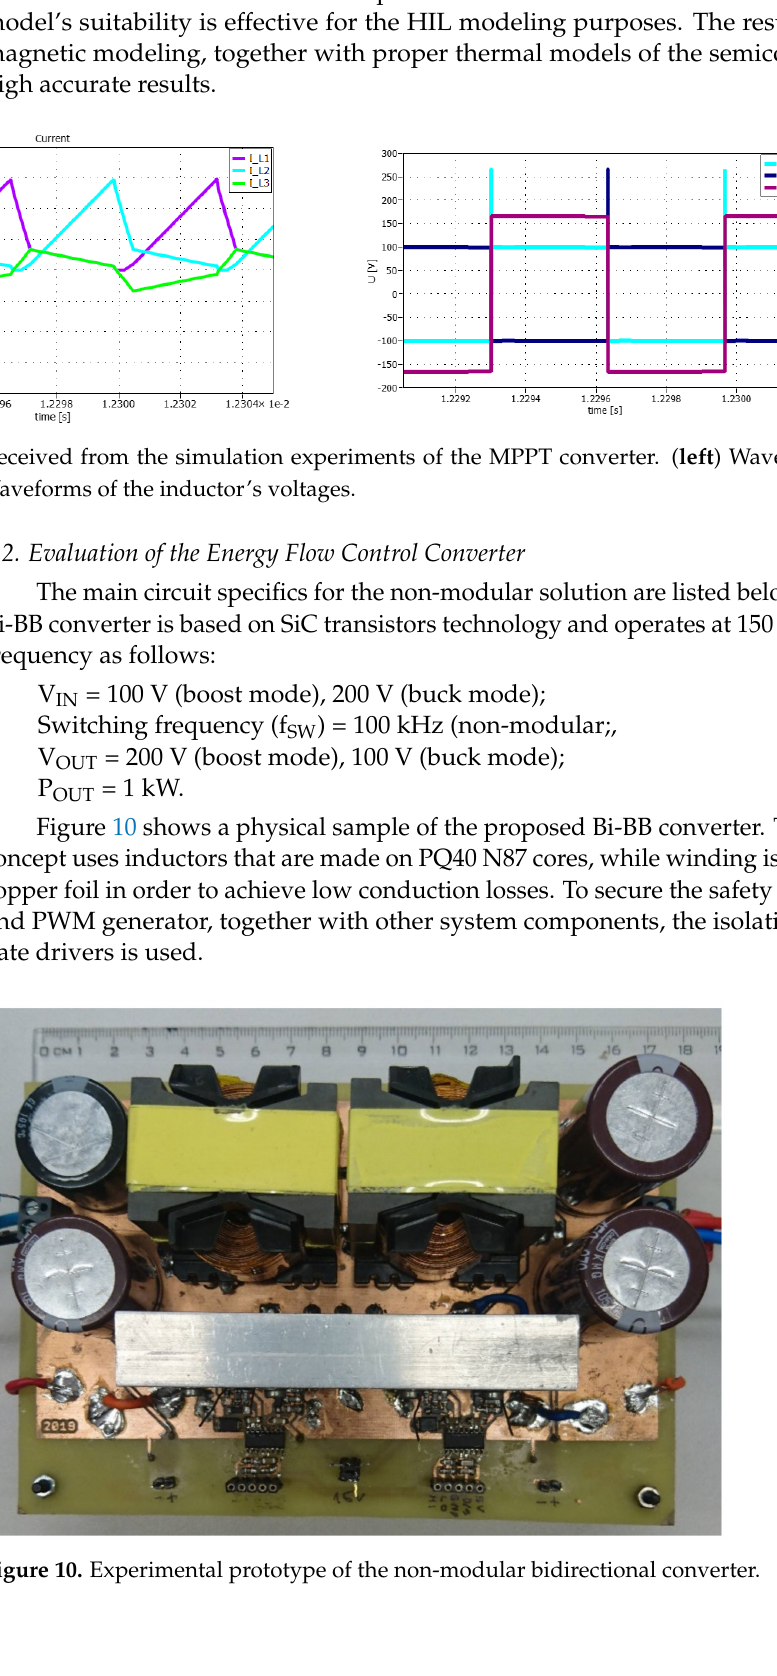
8 of 19 Figure 8. Time waveforms received from experimental measurements of the MPPT converter. ( left ) Waveforms of the inductor’s currents; ( right ) Waveforms of the inductor’s voltages. Figure 9 shows the results from the simulation experiments. Similarly, previous sit- uation waveforms for inductor currents and voltages are analyzed. By comparing those